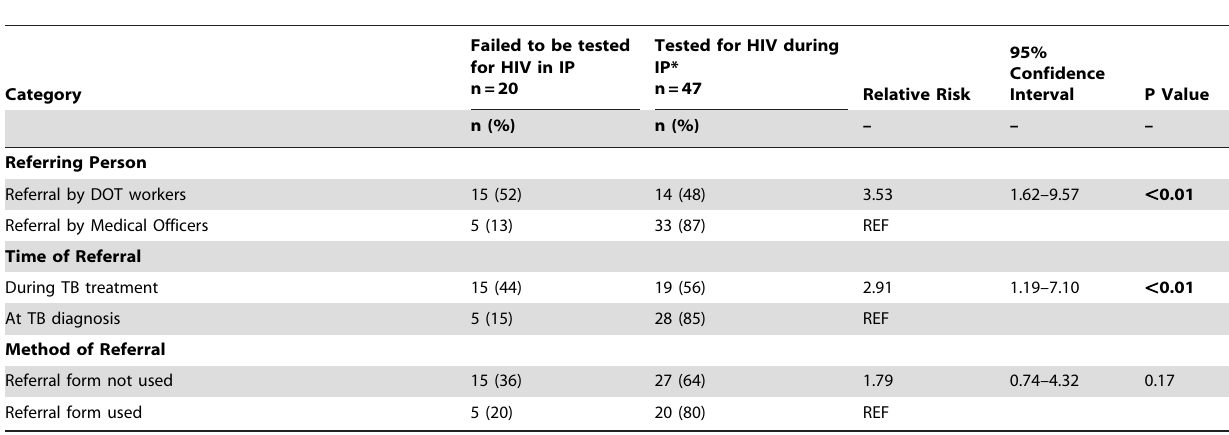
Table 4. Factors associated with failure to be tested for HIV among patients with TB who reported being referred for HIV